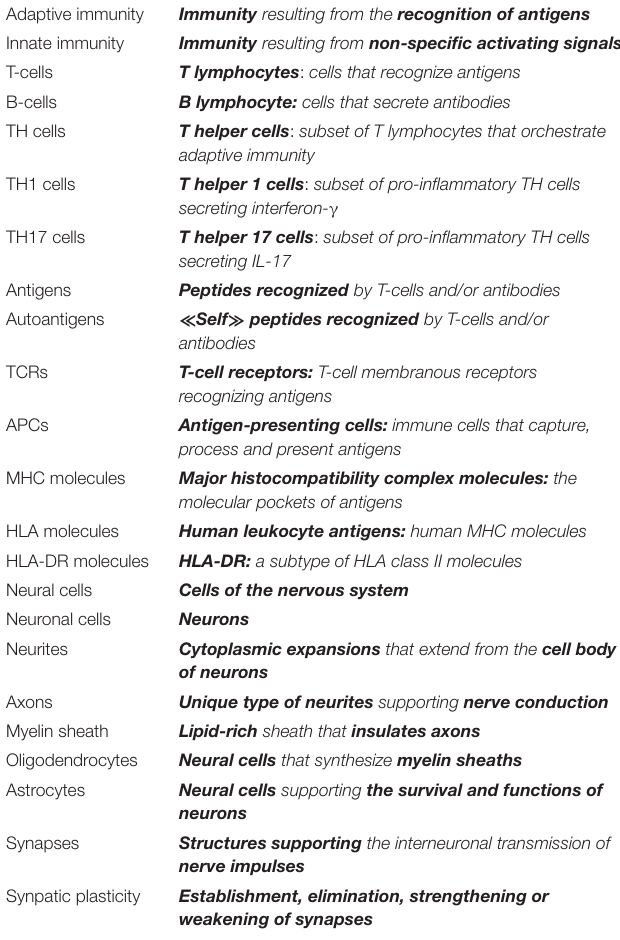
TABLE 1 | Short lexicon of basic neuroimmunology terms. Adaptive